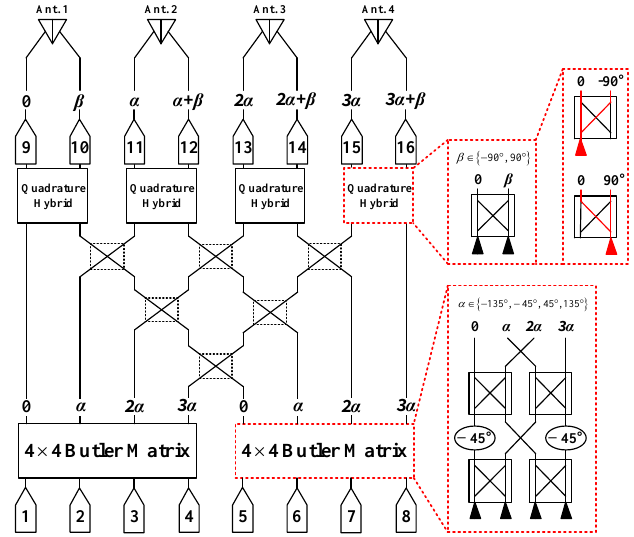
Figure 1. Block diagram of the switched-beam network.